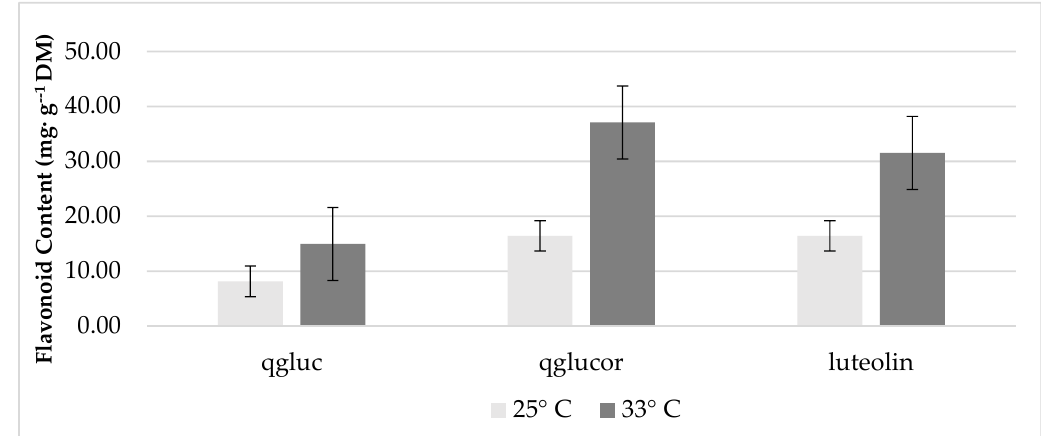
Figure 2. The effect of temperature on concentrations of growth chamber, red ‘Lollo’ lettuce flavonoids. Abbreviations: qgluc- quercetin glucoside; qglucor- quercetin glucuronide. The standard error of the mean was: qgluc ± 1.77; qglucor ± 7.20; luteolin ± 5.36.